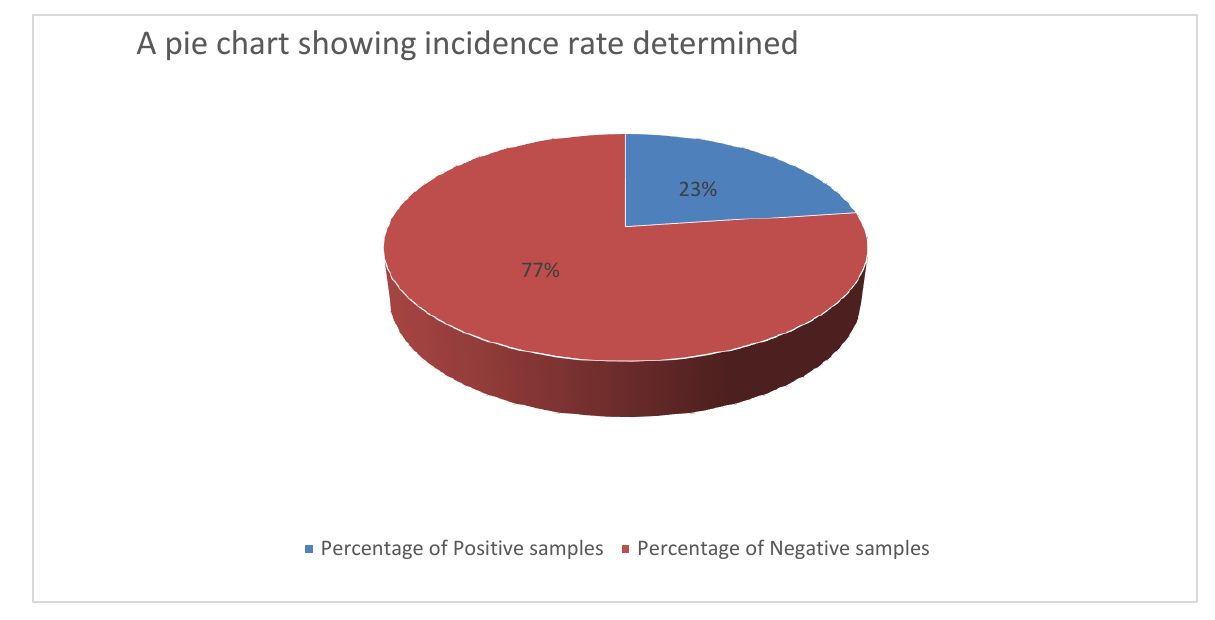
Figure 2. Bar chart showing the distribution of Plasmodium species among positive sample. BAR CHART SHOWING THE DISTRIBUTION OF PLASMODIUM SPECIE AMONG POSITIVE